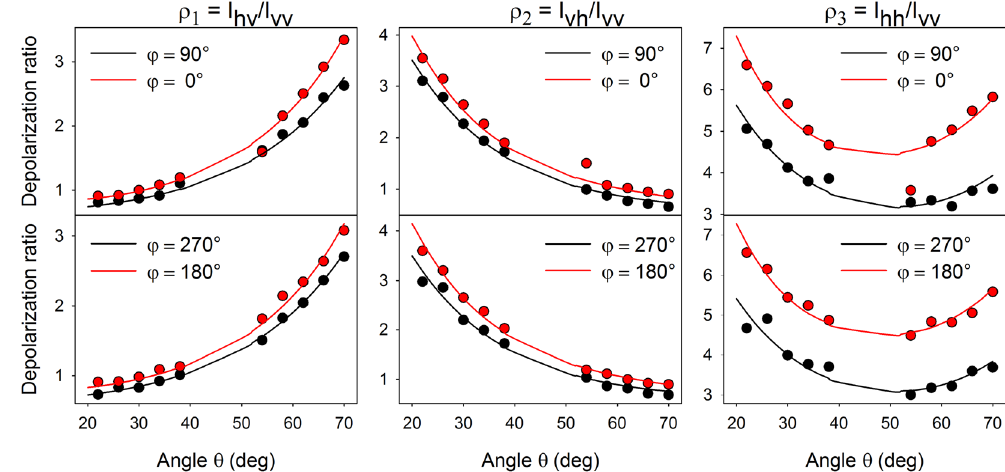
Figure 5. Depolarization ratios of the 1628-cm − 1 MB band for different angular arrangements (colour points) and their fit by the surface selection rules with pseudo-refractive indices obtained from ellipsometry measurements